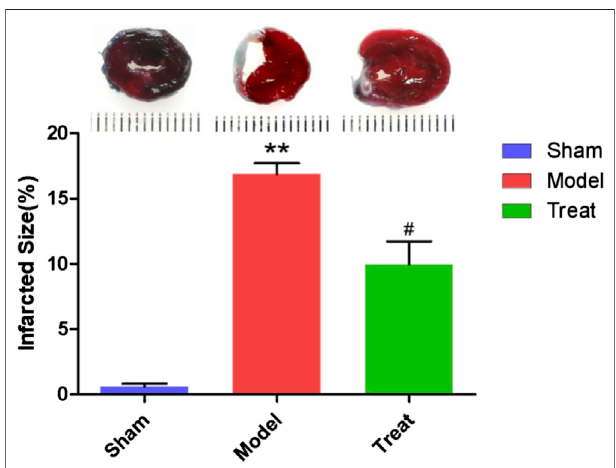
FIGURE 3 | Representative images of EB/TTC double staining of rat heart sections and myocardial infarction area of each group. Data were expressed as mean ± SD ( n (cid:1) 6), ** p < 0.01 compared with the Sham group, # p < 0.05 compared with the Model